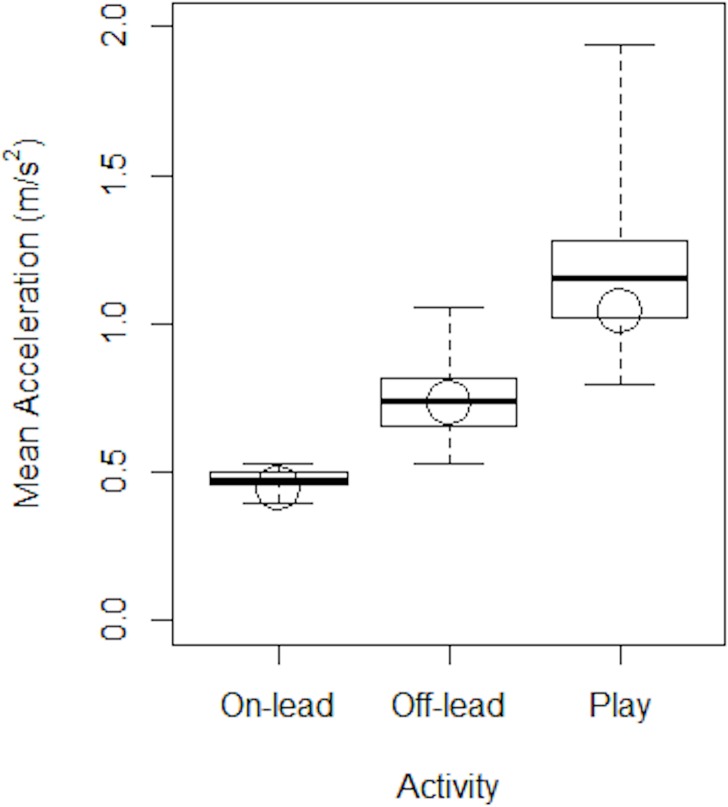
Mean Acceleration for healthy dogs during on-lead and off-lead walks and play.Box and whisker plot showing the difference between the three activities as assessed using Mean Acceleration for healthy dogs. Circles denote the individual data for Dog eight on the second day, and the box and whiskers show the median value and interquartile ranges.